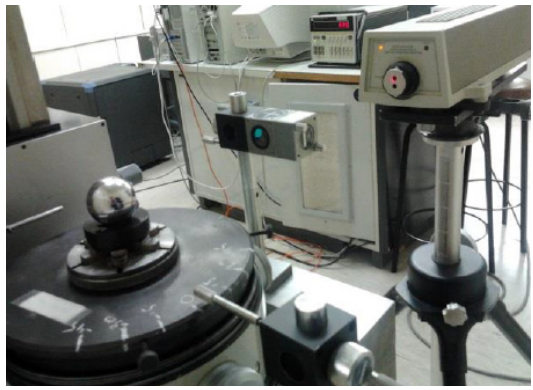
Figure 2. Roundness table SMR test.